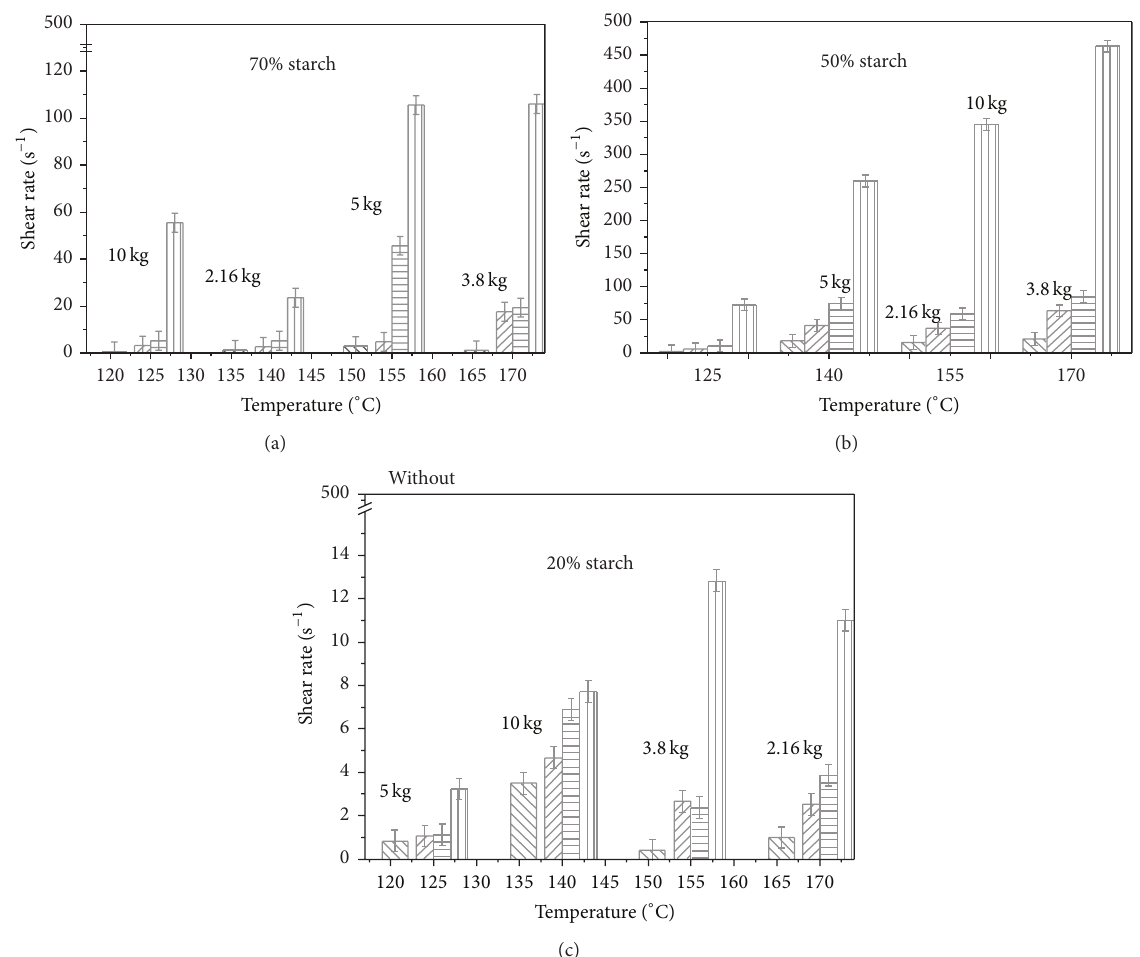
Figure 3: Shear rates versus blend composition and indexer’s measurement